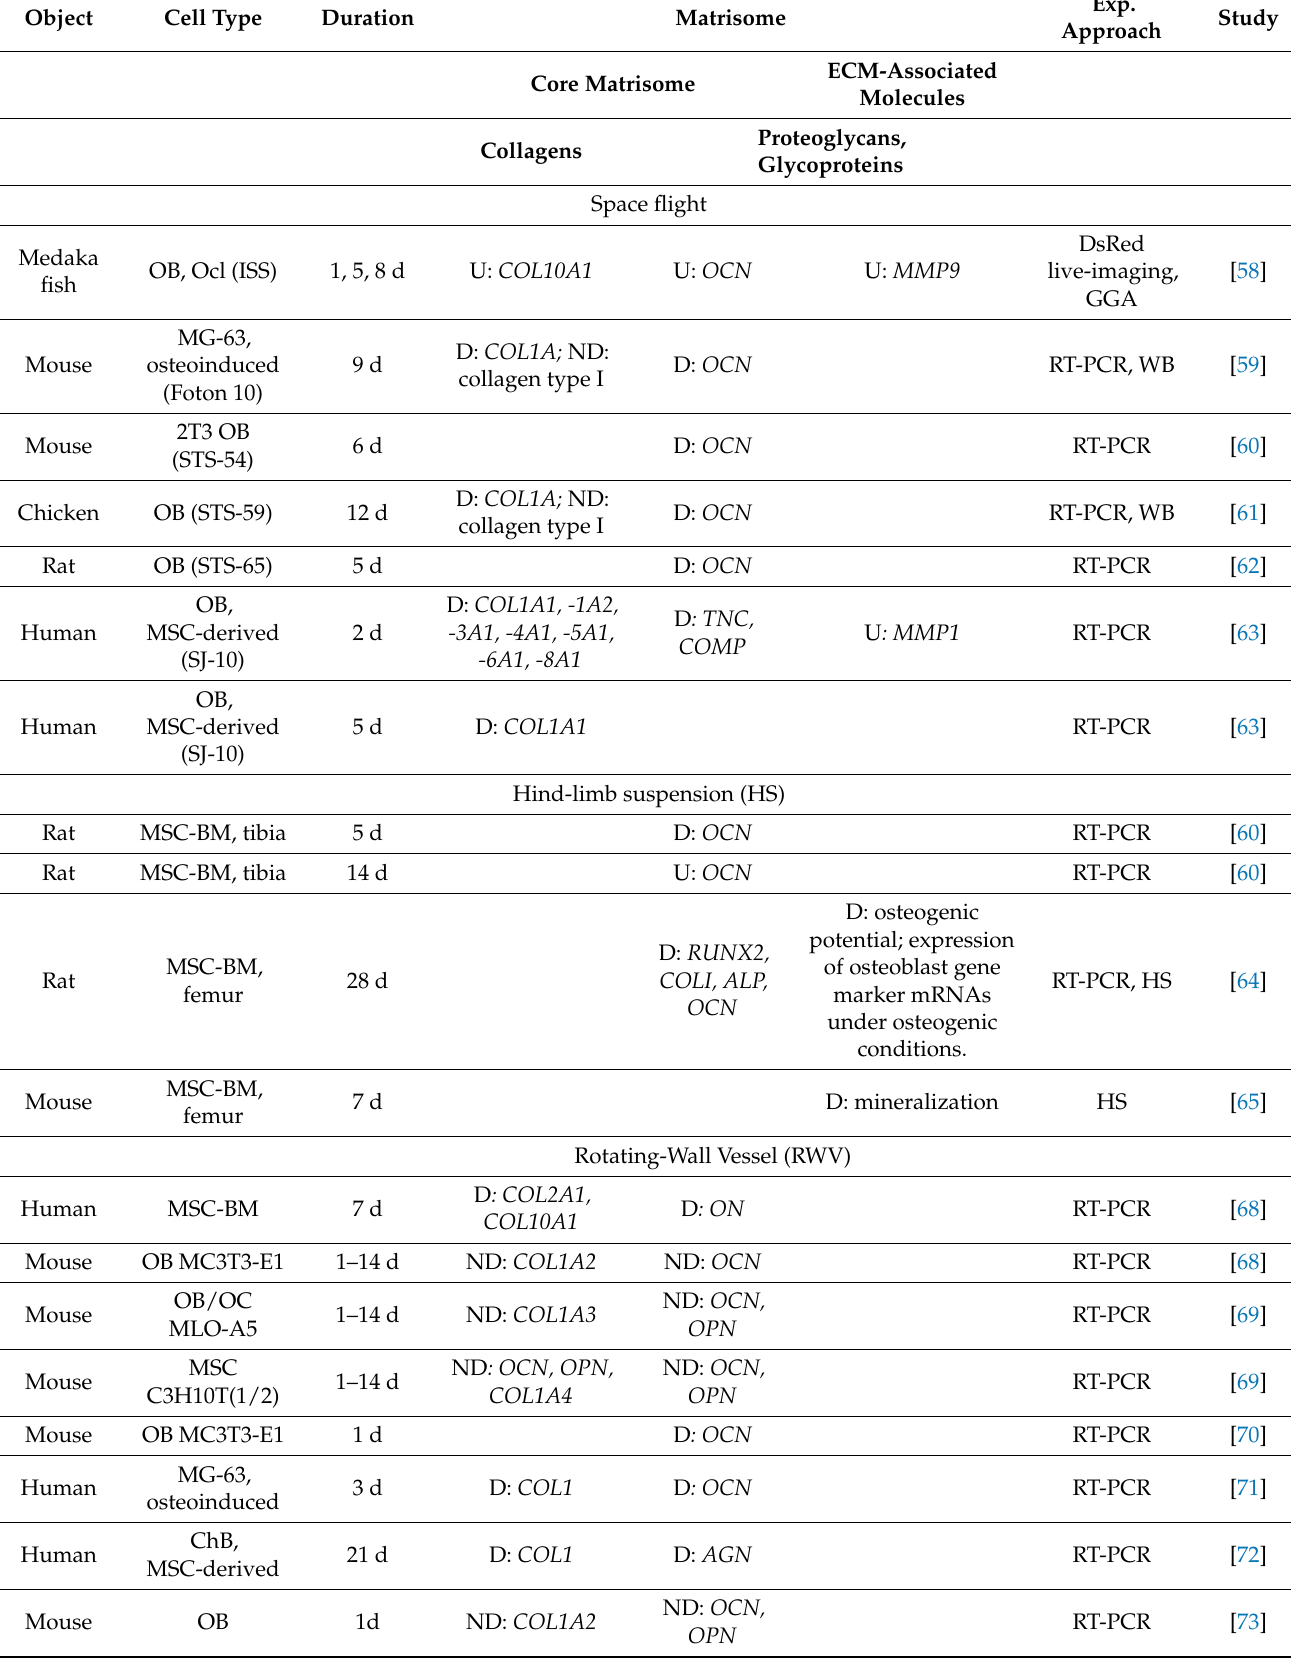
Table 1. The effects of real microgravity and its simulation on matrisome components of stromal lineage cells.